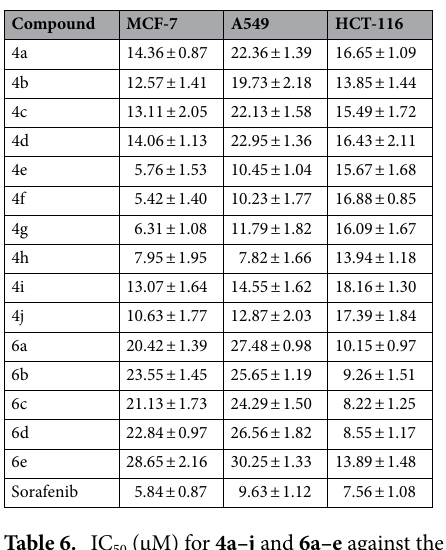
Table 6. IC 50 (μM) for 4a–j and 6a–e against the tested cancer cell lines.